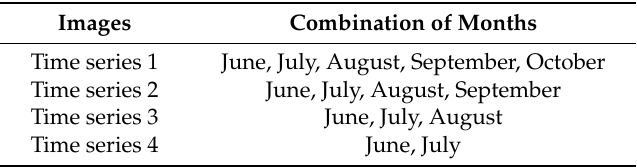
Table 3. Four short time